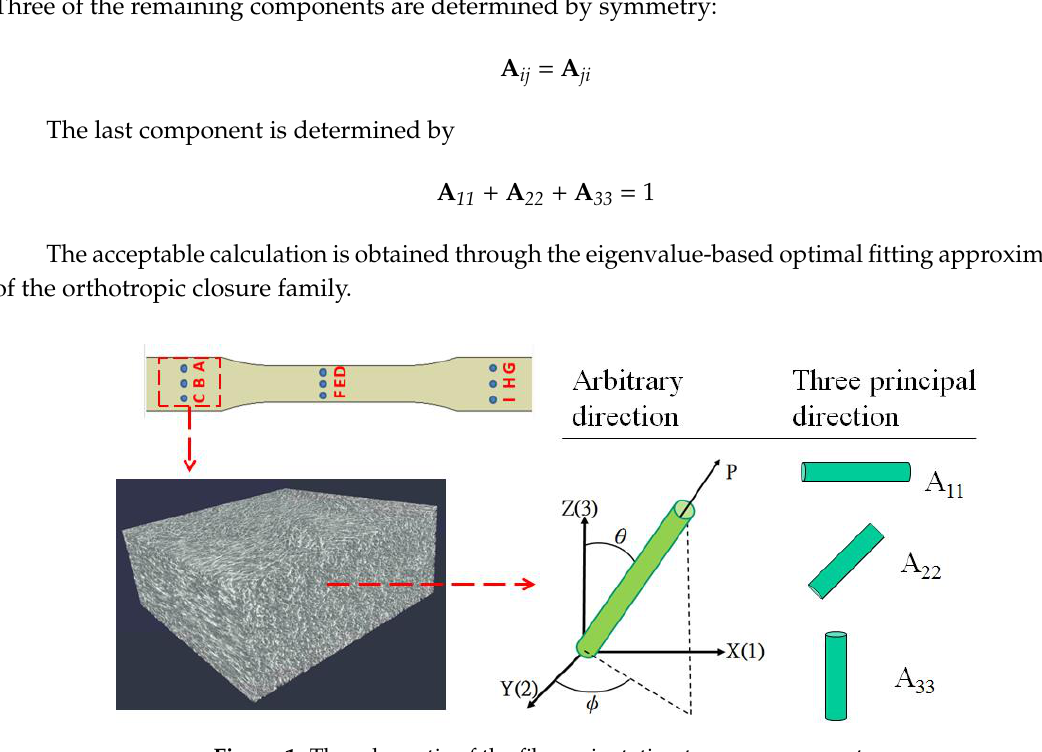
Figure 1. The schematic of the fiber orientation tensor components.